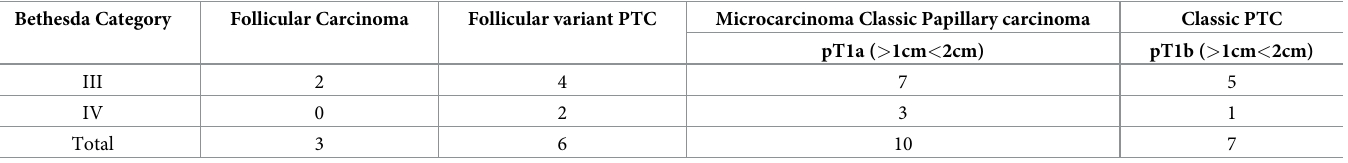
Table 6. Correlation between Bethesda category III and IV and histologic types of carcinoma. Bethesda